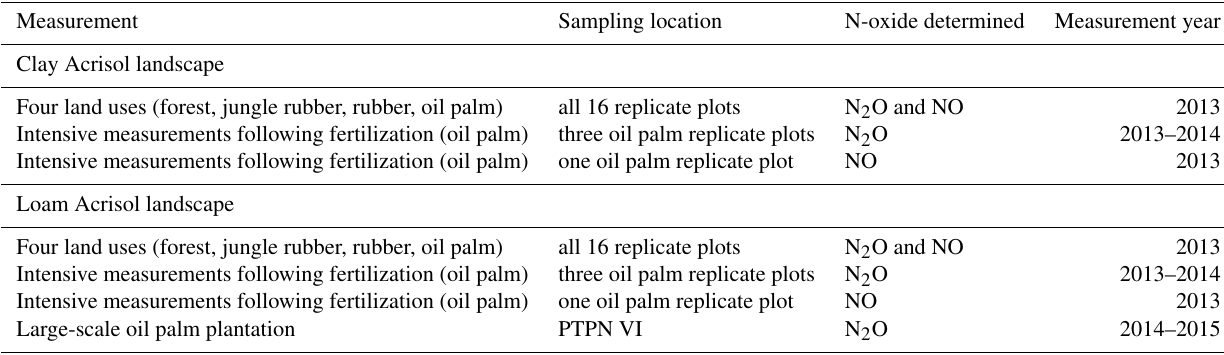
Table A1. Location and year of